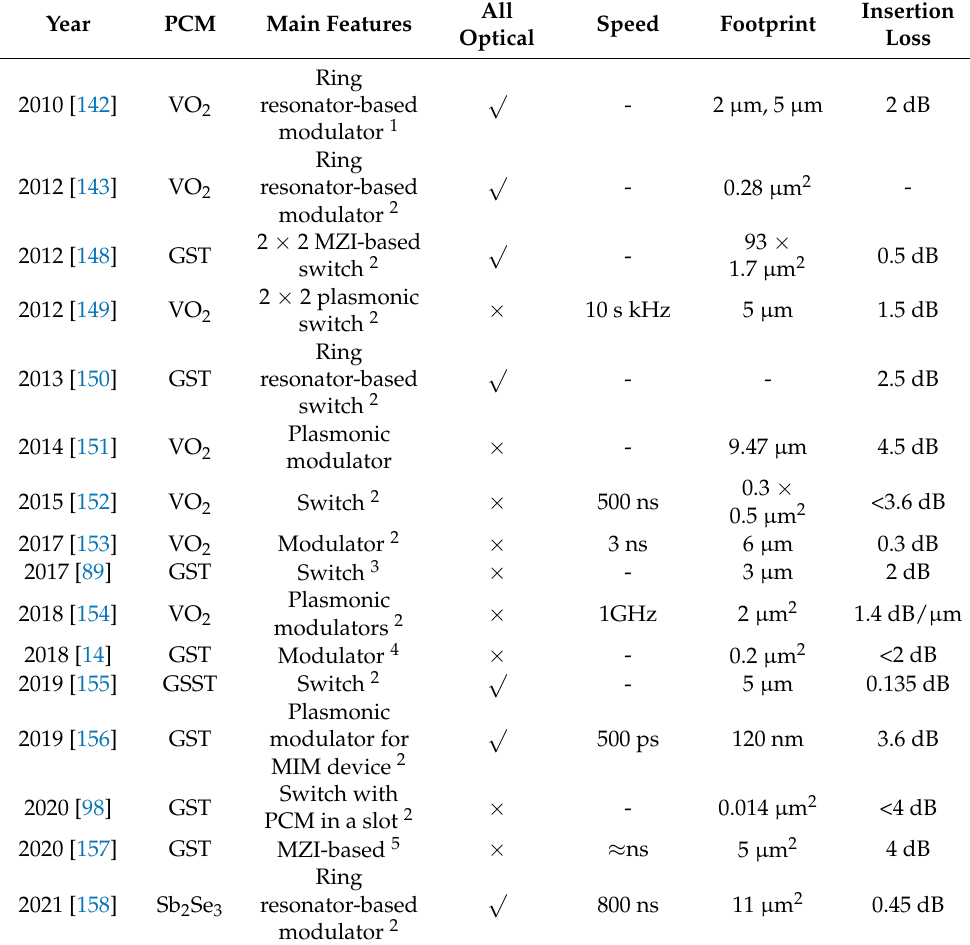
Table 5. Major contributions in PCM-based photonic switches and